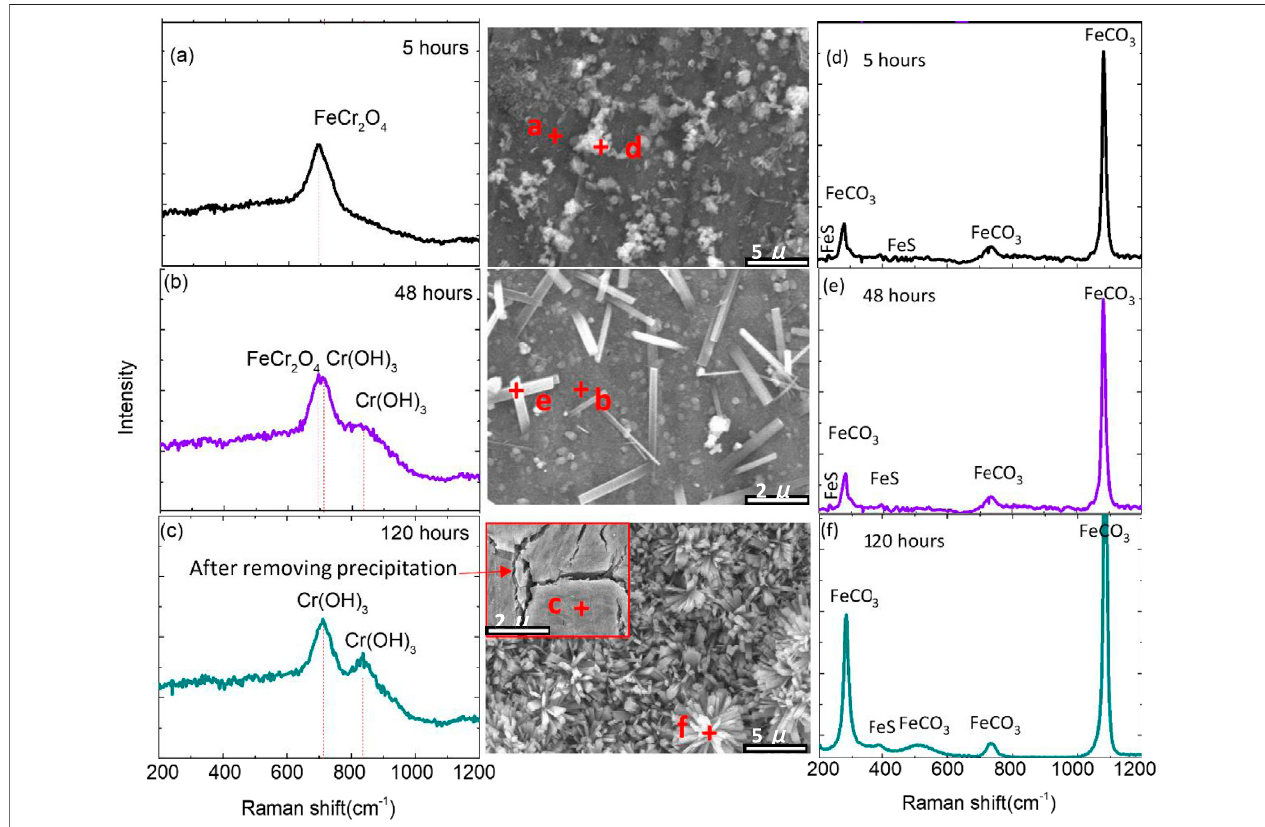
FIGURE 6 | Raman spectra of the corrosion scale formed on S13Cr SS after (A,D) 5 h, (B,E) 48 h, and (C,F) 120 h immersion time under CO 2 -saturated formate condition at 180 ° C.